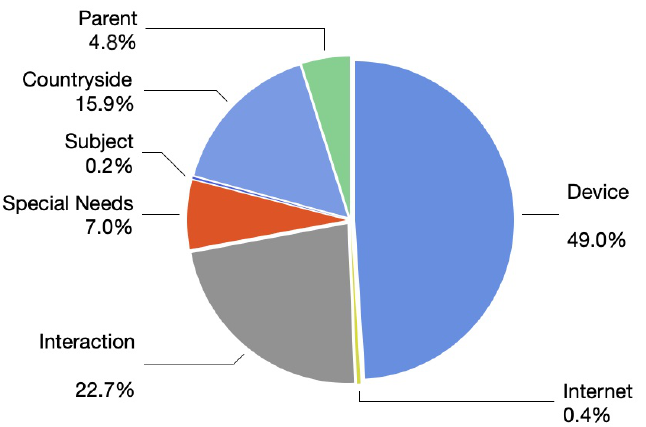
Figure 5. Volume of tweets by keywords.